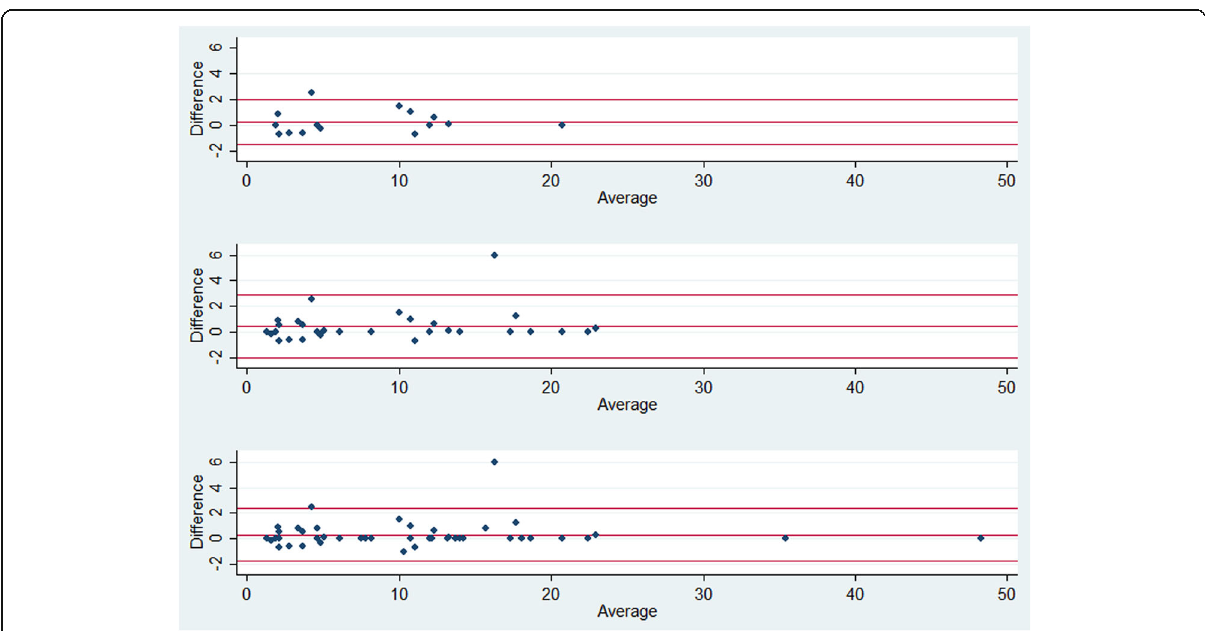
Fig. 2 Bland-Altman plots: upper, middle, and lower panel plots comprise N = 15, 30, and 45 patients,